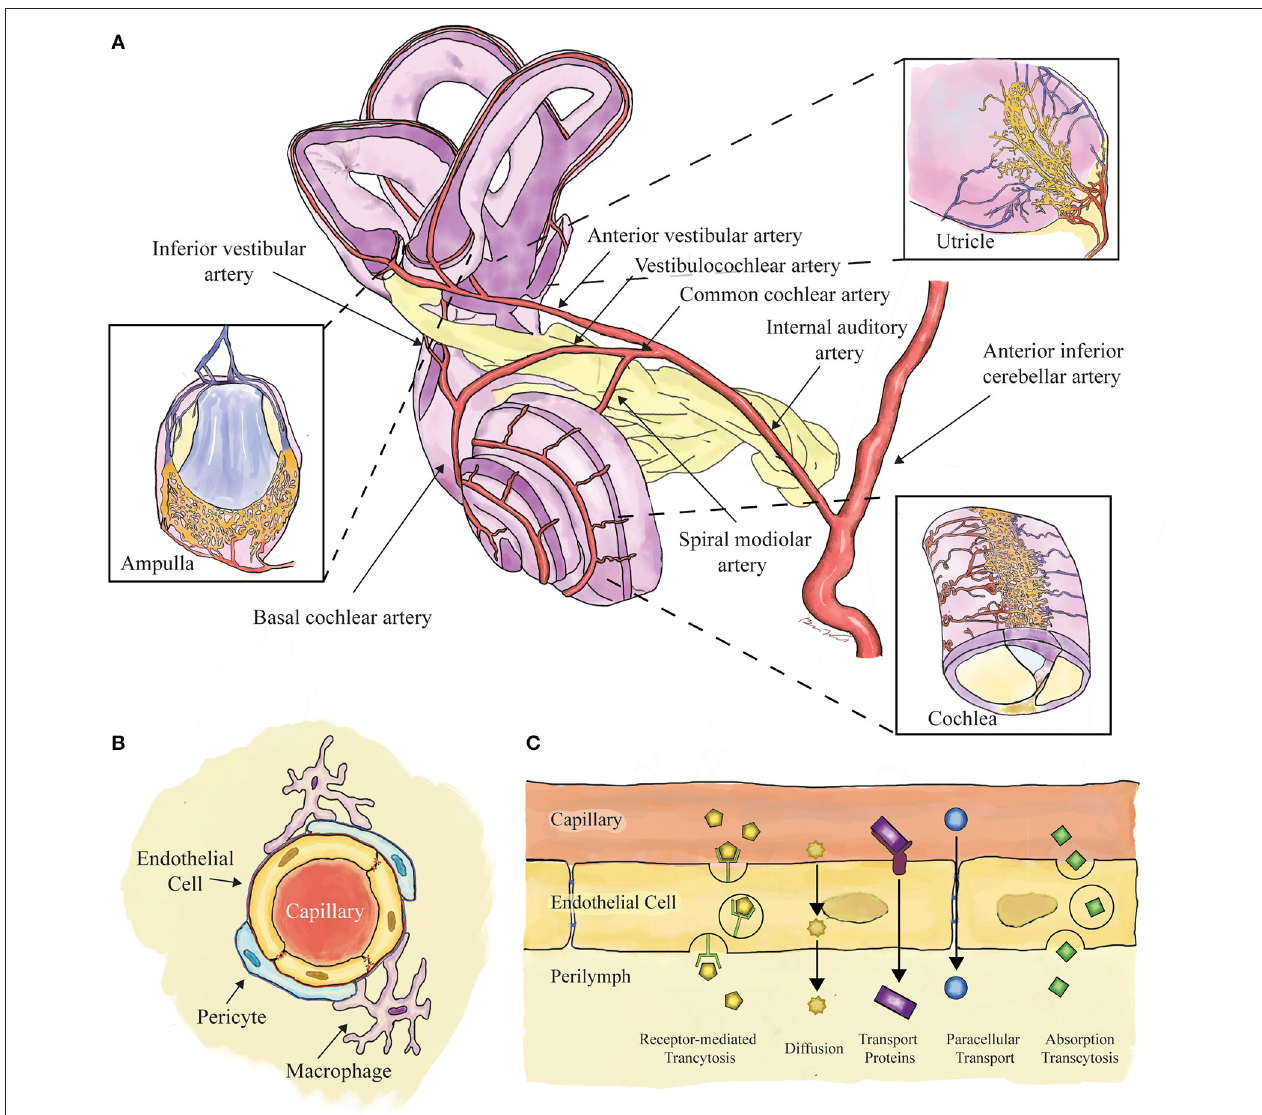
FIGURE 1 | Schematic showing the components of the blood-labyrinth barrier. (A) Blood supply to the labyrinth is shown, with insets showing capillary beds near the sensory epithelia of the ampullae, otoconial organs, and cochlea. (B) Capillaries of the blood-labyrinth barrier include endothelial cells with tight junctions, surrounded by pericytes and resident macrophages that regulate permeability. (C) Examples of hypothetical mechanisms by which molecules can transit across the barrier are